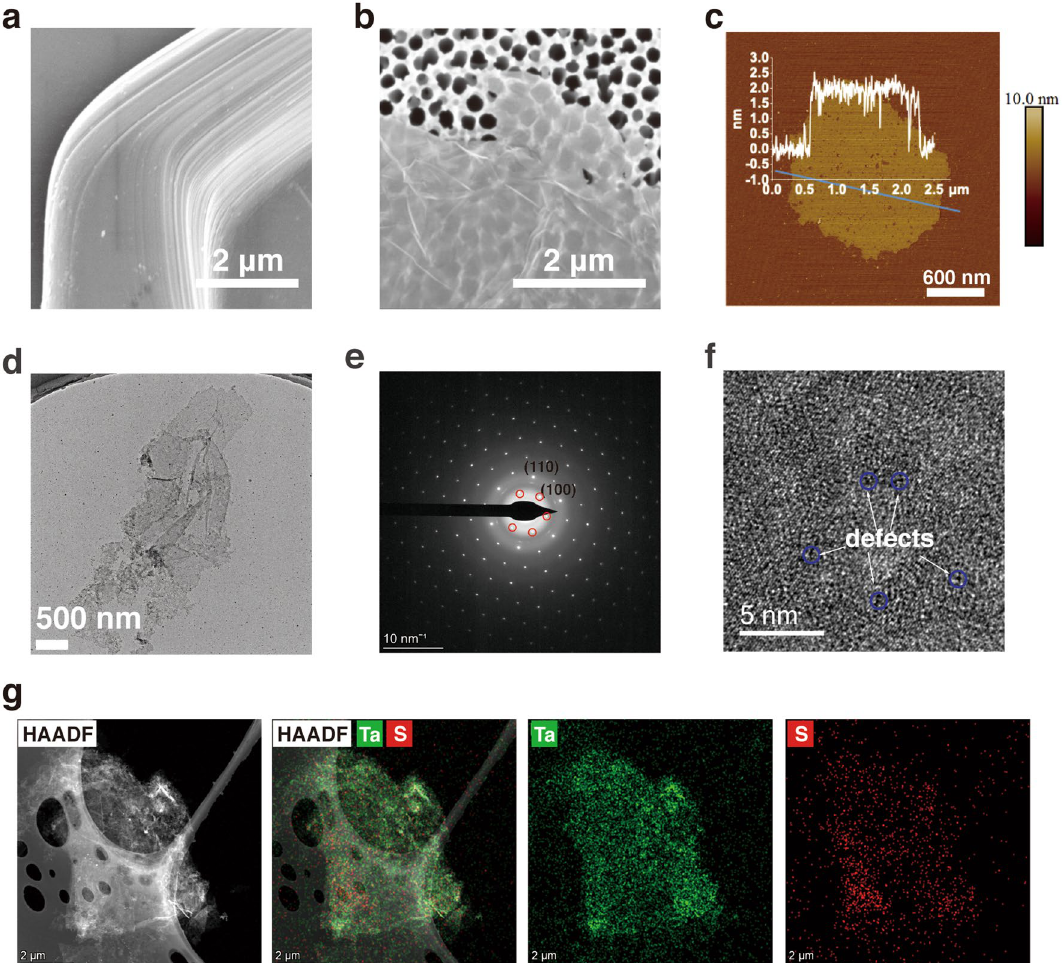
Fig. 3 SEM image of the a 2H-TaS 2 crystals and b 2H-TaS 2 nanosheets. c A typical AFM image of 2H-TaS 2 nanosheets, showing thick- ness of ~ 1.75 nm. d TEM image, e selected-area electron diffraction (SAED) image, f high-resolution TEM image of 2H-TaS 2 nanosheets.